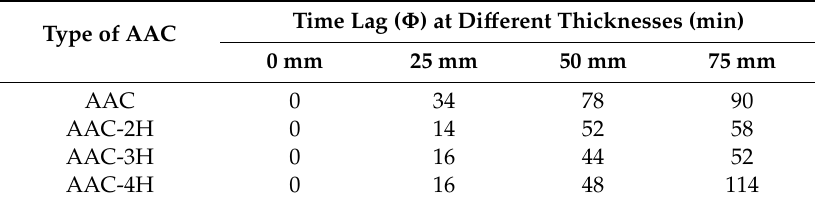
Table 3. Time lag ( Φ ) of AAC wall with di ff erent PCM conical